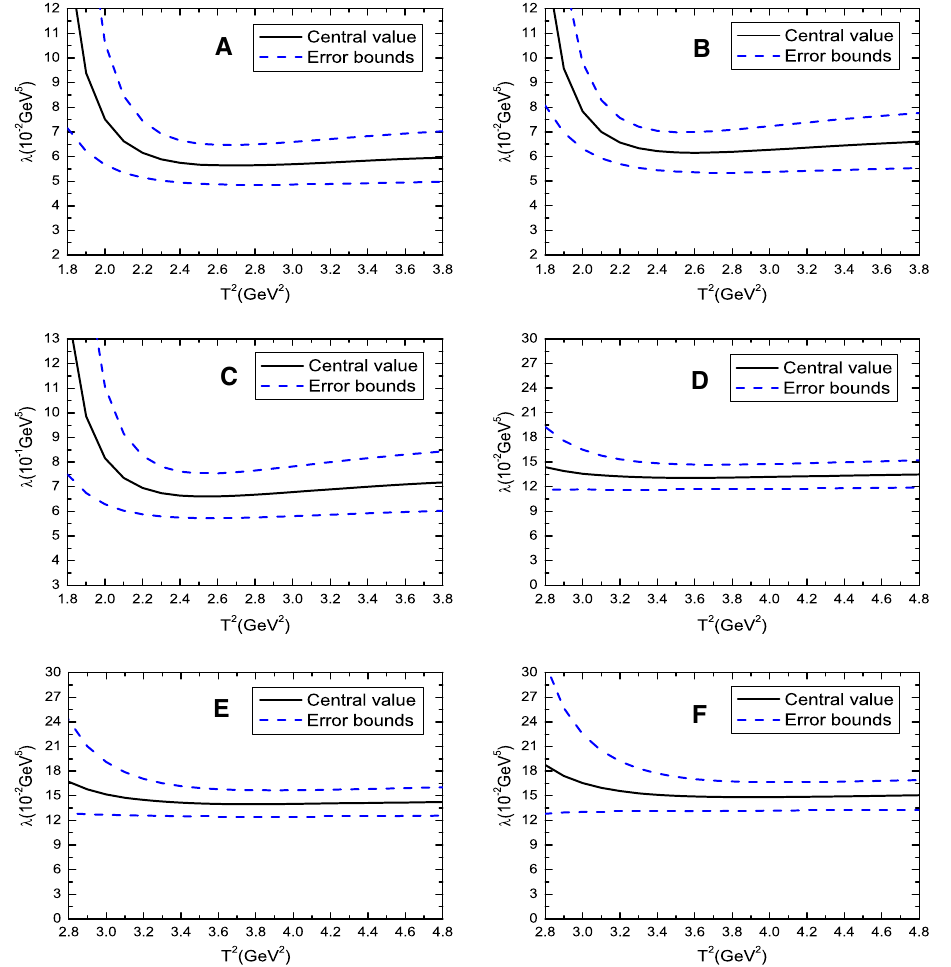
Fig. 5 ThepoleresidueswithvariationsoftheBorelparameters,where a – f denotethetetraquarkstates cc ¯ u ¯ d ( 2 + ) , cc ¯ u ¯ s ( 2 + ) , cc ¯ s ¯ s ( 2 + ) , cc ¯ u ¯ d ( 1 − ) , cc ¯ u ¯ s ( 1 − ) and cc ¯ s ¯ s ( 1 − ) ,